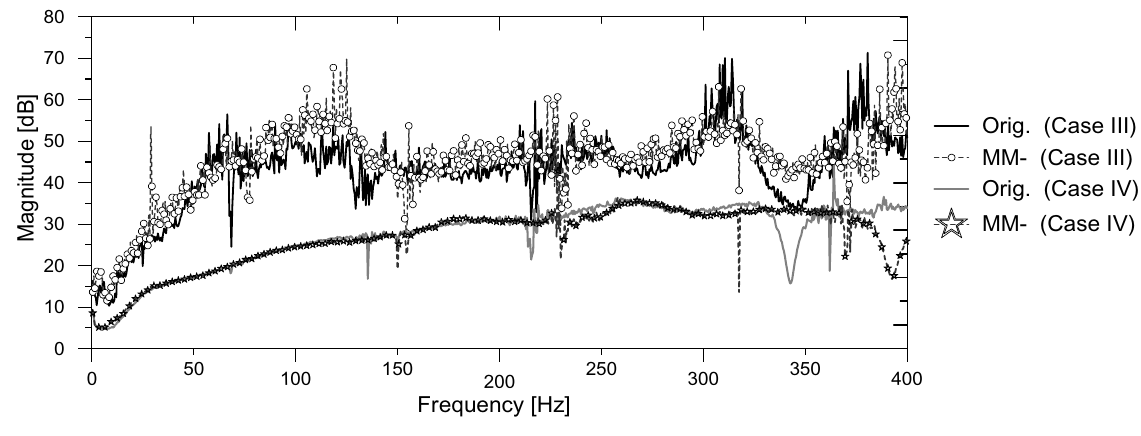
Fig. 15. Transmissibility Indicator for case studies III and